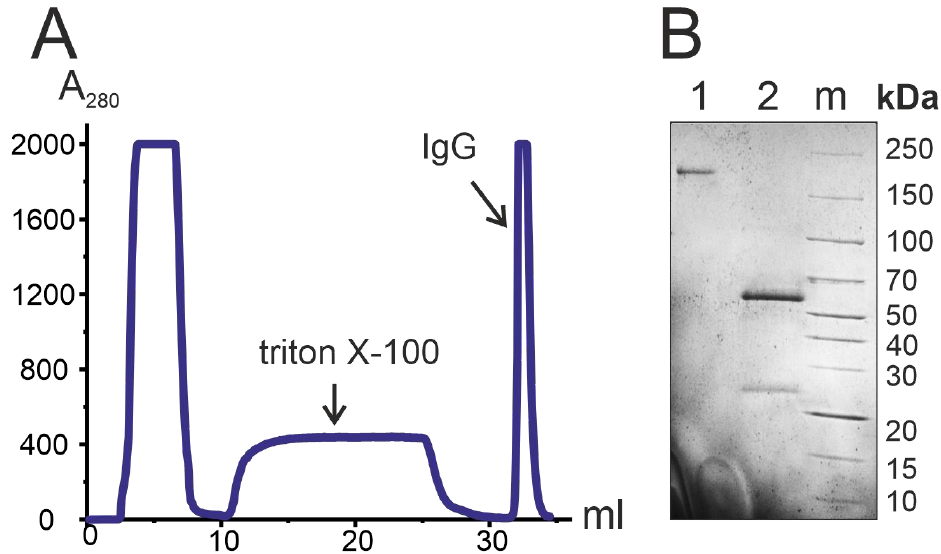
Figure 1. Isolation and electrophoretic analysis of IgG preparation. Profile of IgG isolation from blood plasma of one patient using affinity chromatography on Protein-G-Sepharose ( A ). SDS-PAGE homogeneity analysis of one of the IgG preparations in 4 – 18% gradient gel ( B ): 1 — Intact IgG preparation; 2 — IgG boiled with 40 mM DTT; m — protein molecular weight marker (Thermo Scientific, Waltham, MA, USA).